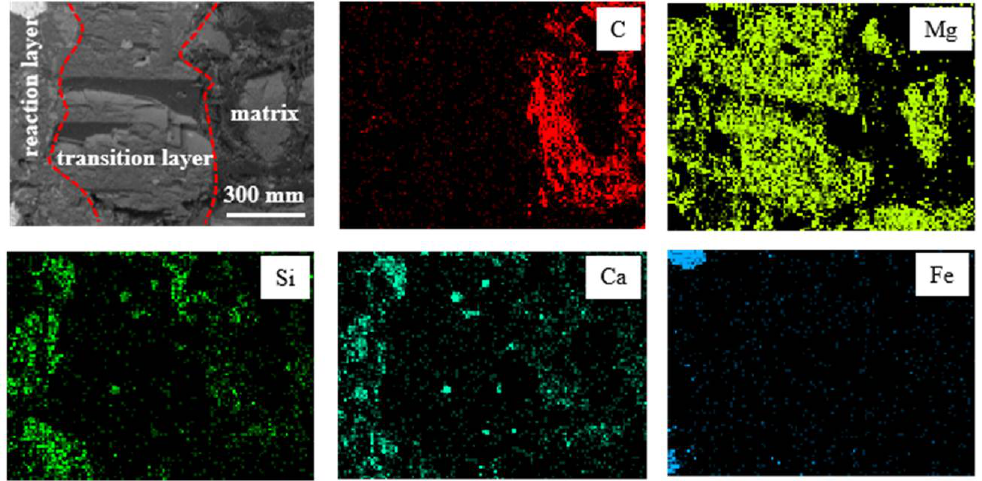
Figure 4. Longitudinal sectional microstructure and element mapping of the ladle furnace slag line MgO-C bricks.